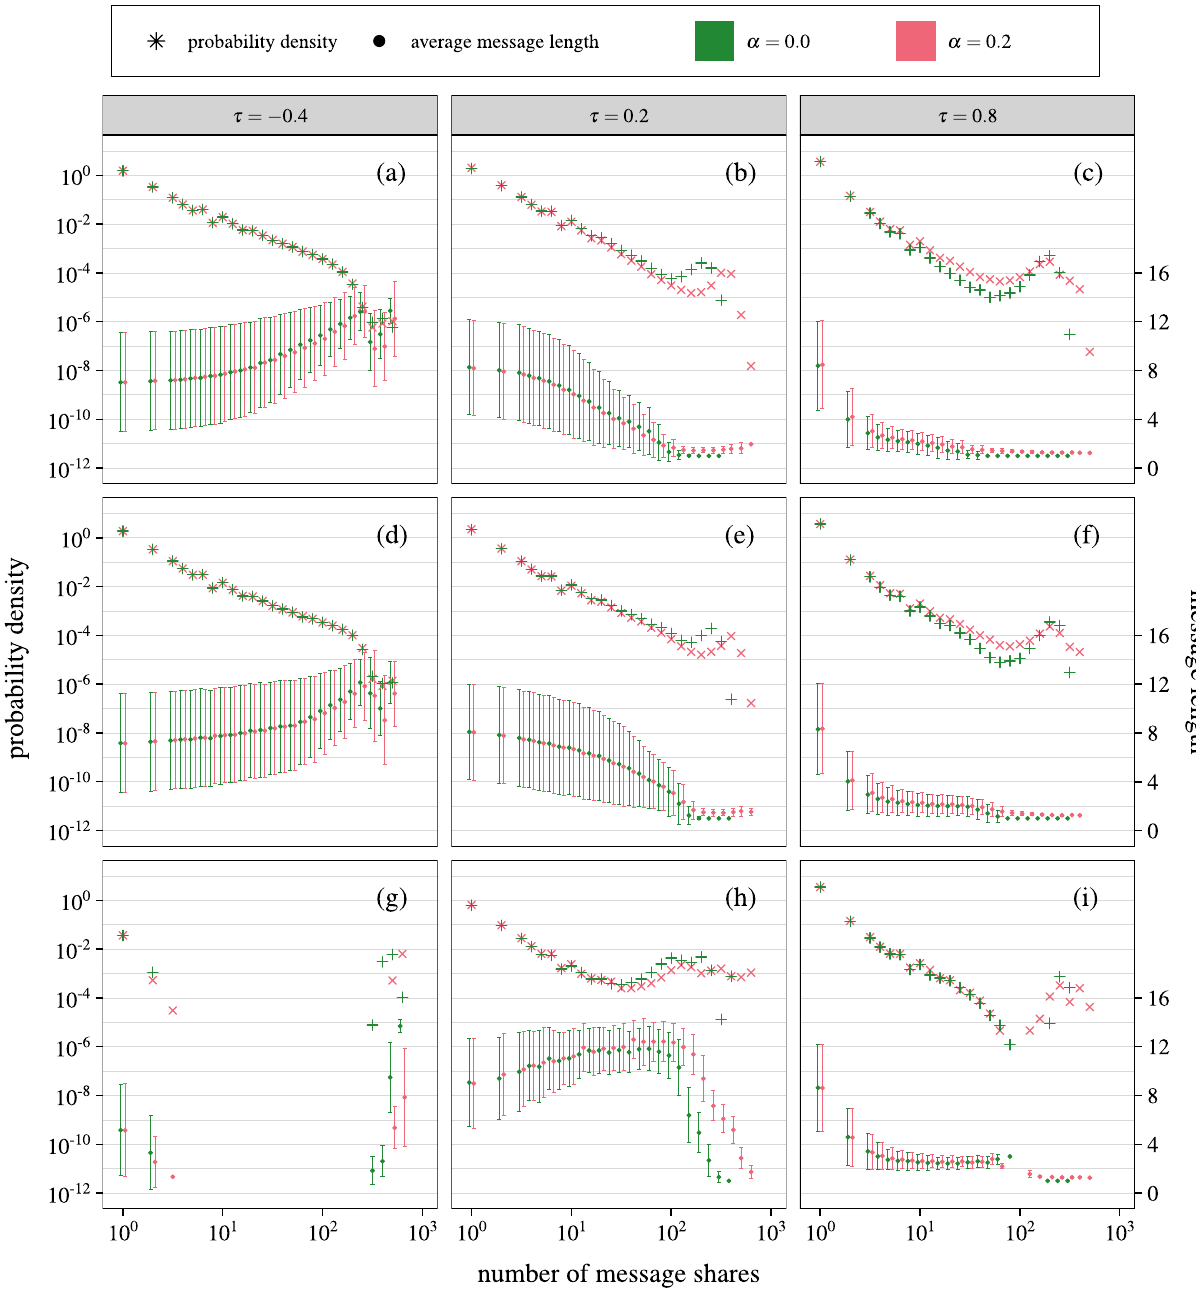
Figure 2. In majority of situations the popularity distribution of messages is a power-law distribution, with the tail dominated by very short messages. The figure shows the influence of user selectivity τ and message adaptivity α on the popularity and on the average length of messages propagating in synthetic networks. Panels ( a )–( f ) show spreading with competition between messages (agents can share only the most recent message he likes), while panels g-i show spreading without this constraint. Panels ( a )–( c ) present the popularity for ER networks and 500, 000 time steps, d-f for BA networks with 500, 000 time steps and g-i for ER network, but with a shorter time horizon—50,000 time steps. The simulations were carried out for networks with size N = 600 and an average node degree � k � = 6 . The agents’ opinion vectors were randomly selected. The probability of creating a new message equals η = 0.1 . The probability density of the number of shared messages (left vertical axis) is marked with crosses and pluses. The average length of the message (right vertical axis) with a given popularity is marked with dots, and its standard deviation with error bars. Columns correspond to τ = − 0.4 , 0.2 and 0.8, green symbols are for simulations without adaptivity ( α = 0 ), while red symbols with adaptive messages ( α = 0.2